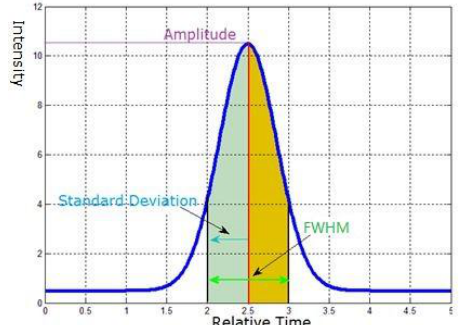
Figure 2. The diagram of intensity and FWHM